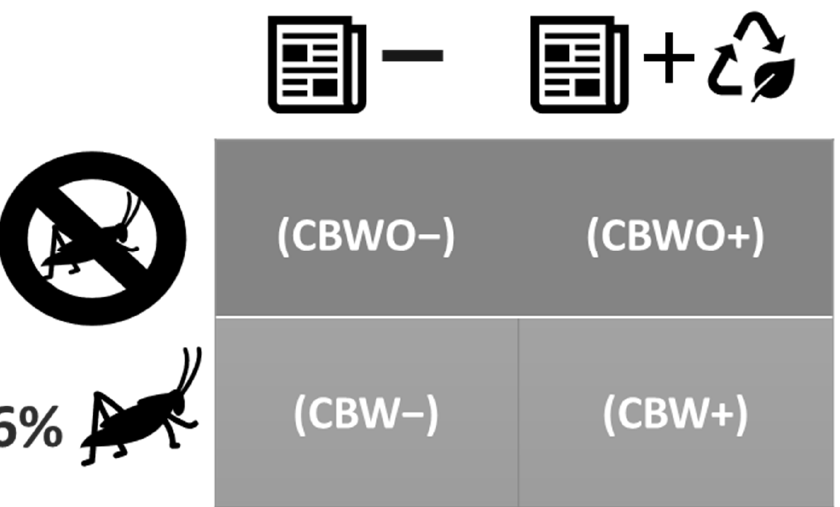
Figure 1. Factorial arrangement for the chocolate brownie (CB) treatments. ECP = Edible-cricket protein. WO: Without; W: With. ECP − : “No ECP added” disclosed information; ECP+: “Contains ECP + benefits” disclosed information. (1) CBWO − = CB without ECP (CBWO) presented under the ECP − disclosed information; (2) CBWO+ = CBWO presented under the ECP+ disclosed information; (3) CBW − = CB with 6% ECP (CBW) presented under the ECP − disclosed information; (4) CBW+ = CBW presented under the ECP+ disclosed information .